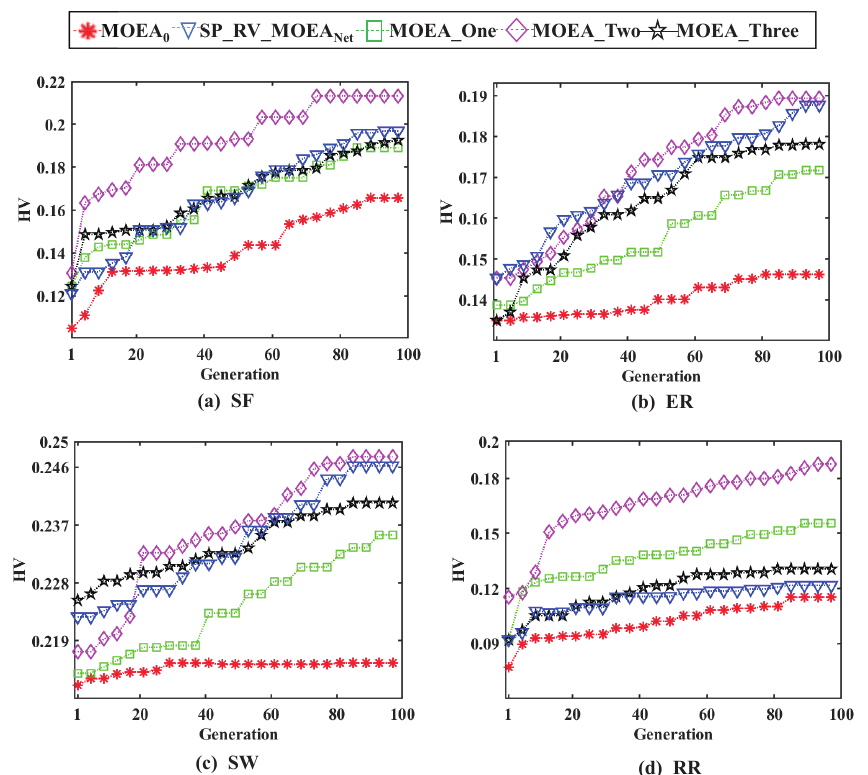
Figure 4. HV values of different methods under four types of complex